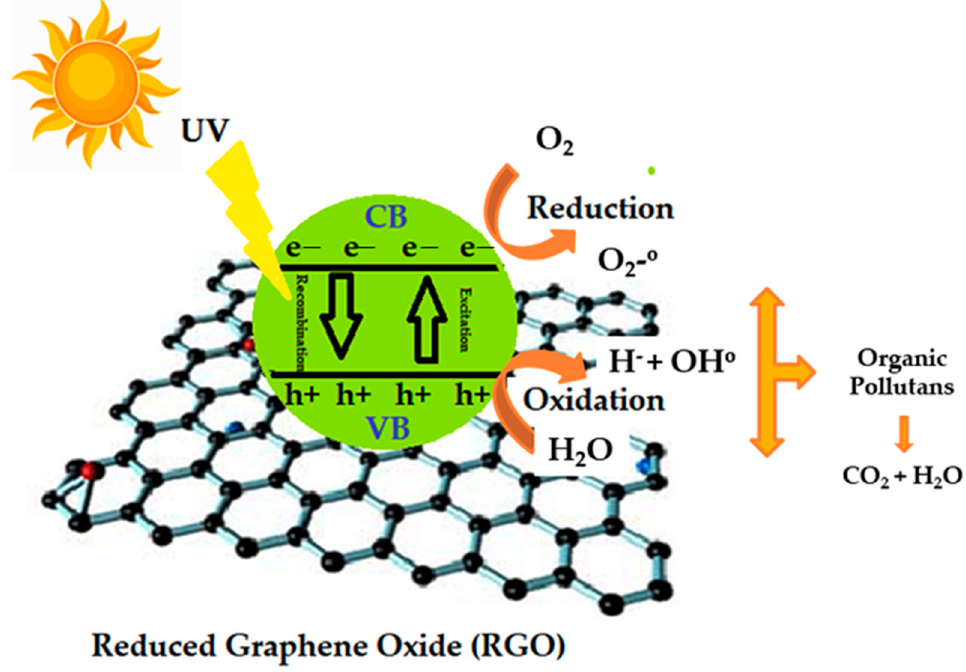
Figure 1. General scheme of photocatalysis.